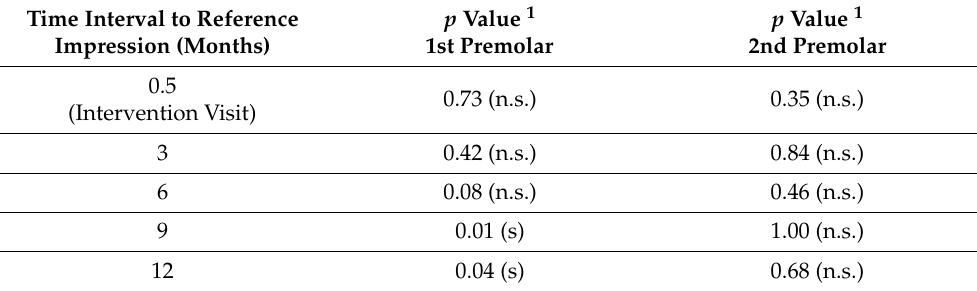
Table 5. Comparison of marginal gingiva height change between cord and paste